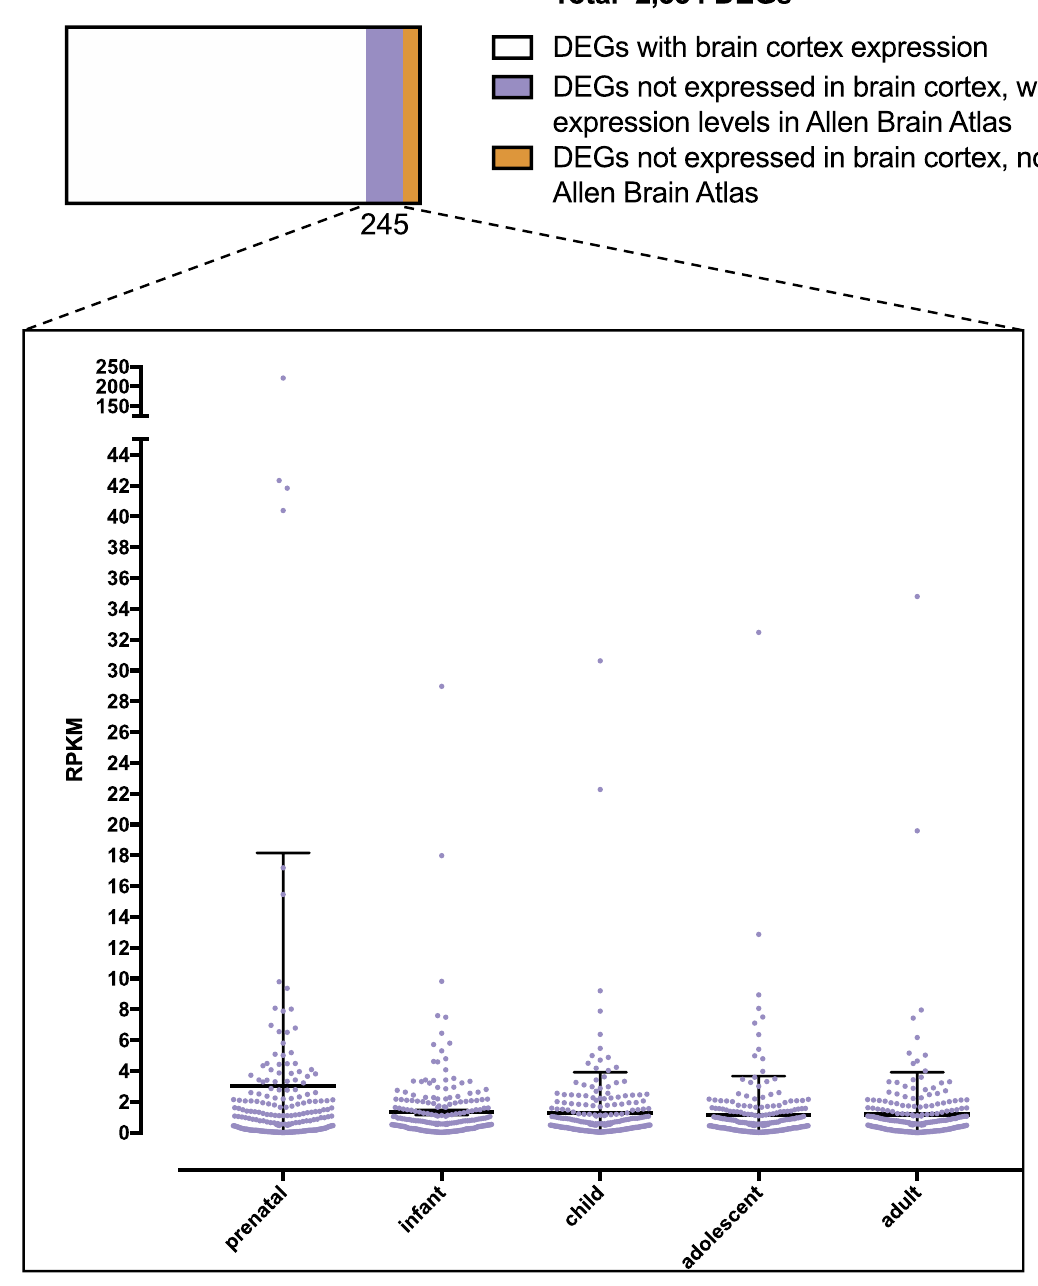
adult vs . prenatal stage =